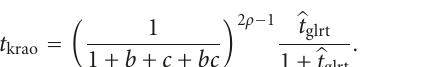
The curves highlight that for small-medium SNR